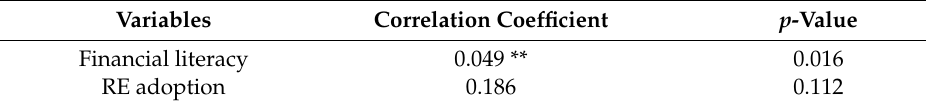
Table A3. Pearson correlation analysis of the selected IV.